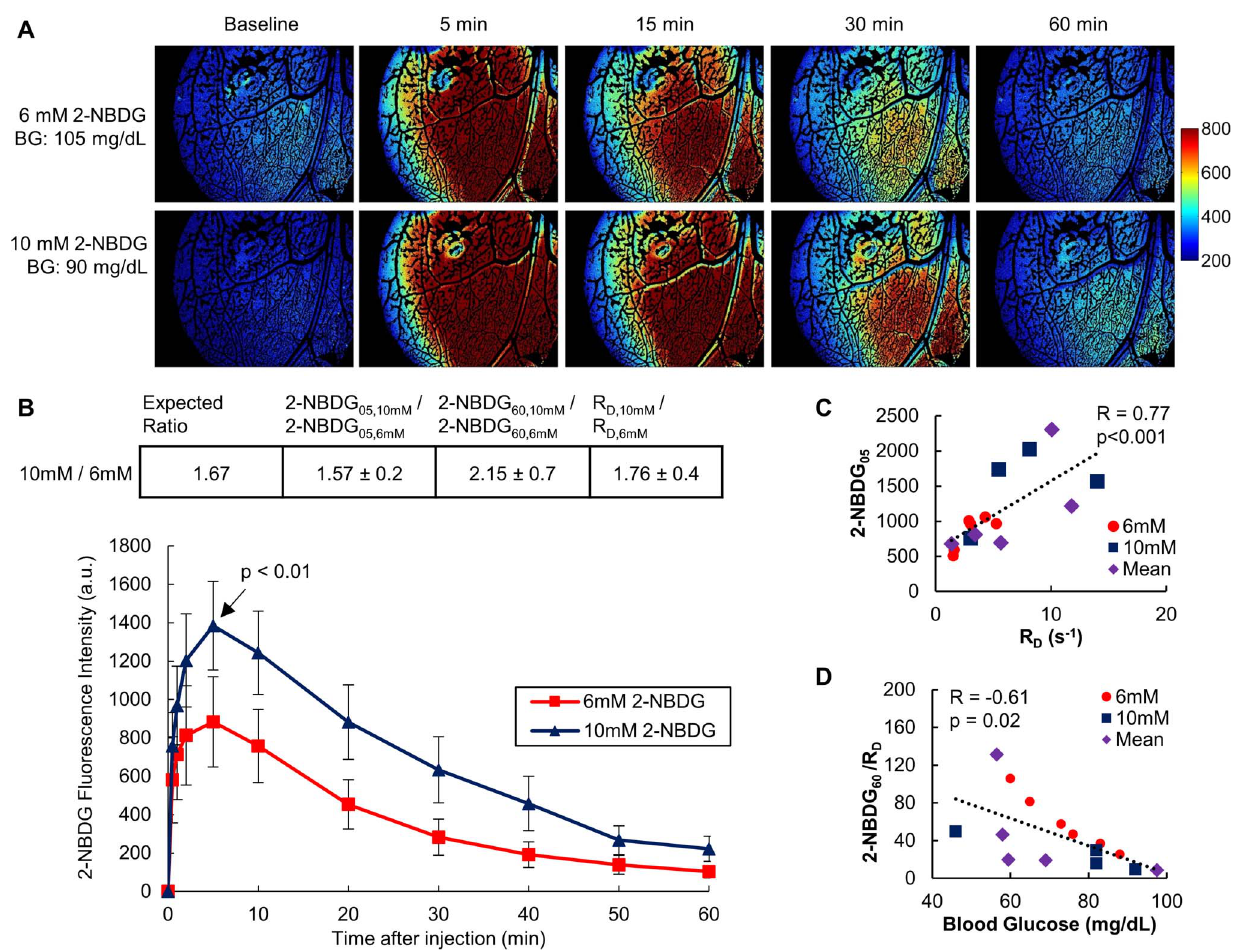
Fig. 2. Delivery-corrected 2-NBDG uptake inversely correlates with blood glucose concentration. (A) Representative images show the kinetics of 2- NBDG uptake in vivo in non-tumor window chambers. The same mouse was given 6 mM or 10 mM 2-NBDG on subsequent days and imaged for 60 minutes following injection. (B) Averaged 2-NBDG kinetics for a cohort of mice injected with 0.1 mL of either 6 mM or 10 mM 2-NBDG. At 5 minutes post- injection (2-NBDG 05 ), the fluorescence ratio of the dose groups (2-NBDG 05,10 mM /2-NBDG 05,6 mM ) was proportional to molarity (p , 0.01). The table shows the expected ratio of 10 mM/6 mM fluorescence, if all differences in fluorescence were due to dose. 2-NBDG 05,10 mM /2-NBDG 05,6 mM corresponds to the ratio of 10 mM and 6 mM fluorescence intensities at t 5 5 min. The ratio R D,10 mM /R D,6 mM corresponds to the rate of 2-NBDG delivery for 10 mM and 6 mM. Each group in panel B contains the same n 5 7 subjects. p values are from a student’s paired t-test. Error bars show standard error. Values in table are mean ¡ standard error. (C) R D was strongly correlated with 2-NBDG fluorescence at 5 minutes (p , 0.001). R D did not correlate with 2-NBDG 60 (not shown). (D) 2- NBDG 60 /R D was inversely correlated with baseline blood glucose in normal mice (R 52 0.61, p 5 0.02). 2-NBDG 60 was also correlated with blood glucose (R 52 0.52, p 5 0.05, not shown). For animals that received both 6 mM and 10 mM doses, the average values of the endpoints (2-NBDG 05 , 2-NBDG 60 , and 2-NBDG 60 /R D ) for both doses were used in calculating the correlations. These subjects are denoted by ‘‘mean’’ in the legend. n 5 15 mice for (C) and